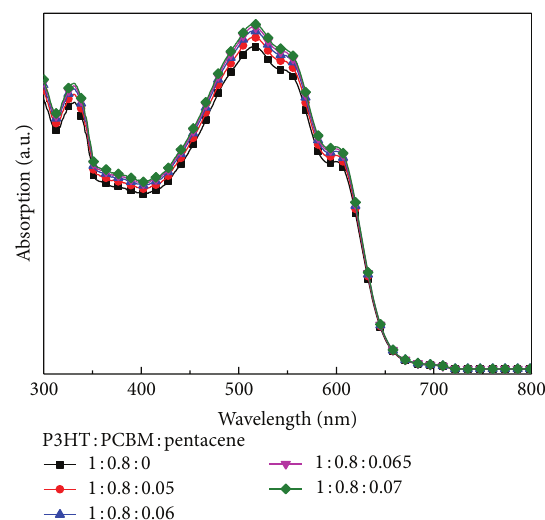
Figure 6: The UV-Vis absorption spectra of the absorption layers with various pentacene doping